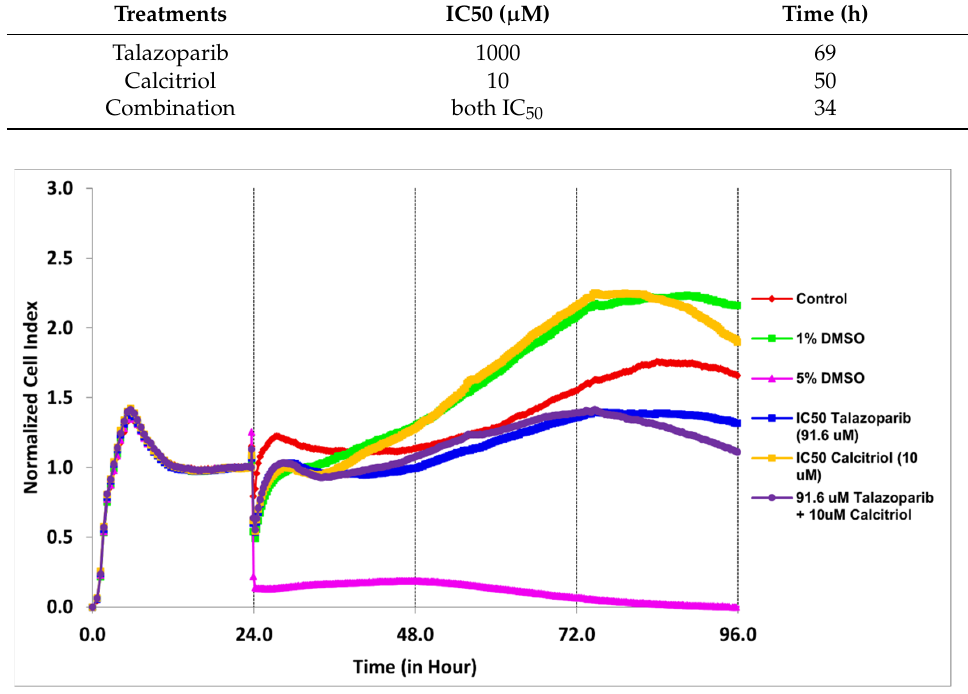
Figure 3. Treatment effects in MRC − 5 using BT − 20 concentrations. Cells were seeded overnight (1 × 10 4 cells/well on E − plates) to reach the log phase, then incubated with IC 50 of 91.6 µM talazoparib and 10 µM calcitriol for 96 h. Data are represented as the mean ± SD ( n = 3). The drugs were added after 24 h. The green color line is the vehicle control (1% DMSO) and the pink color line is the positive control (5% DMSO). Raw data can be found in Supplementary File S3.